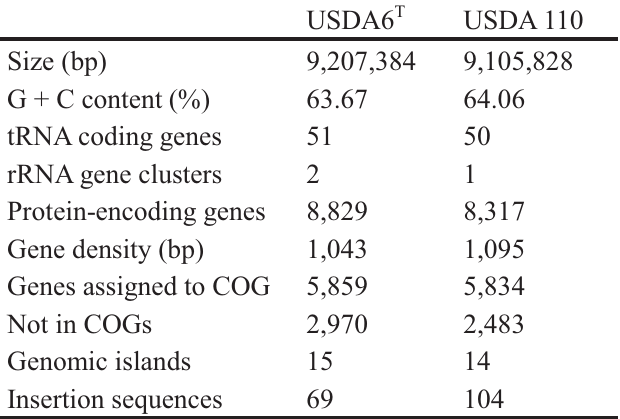
Table 2. General features of USDA6 T and USDA110